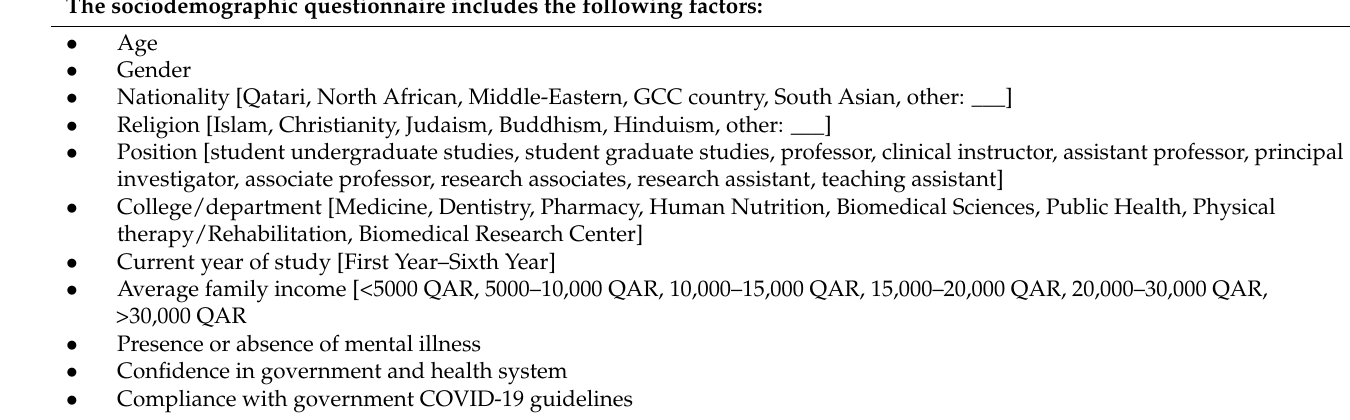
Table A1. Sociodemographic questionnaire, VAX, and CAS scale implemented in this study. The sociodemographic questionnaire includes the following